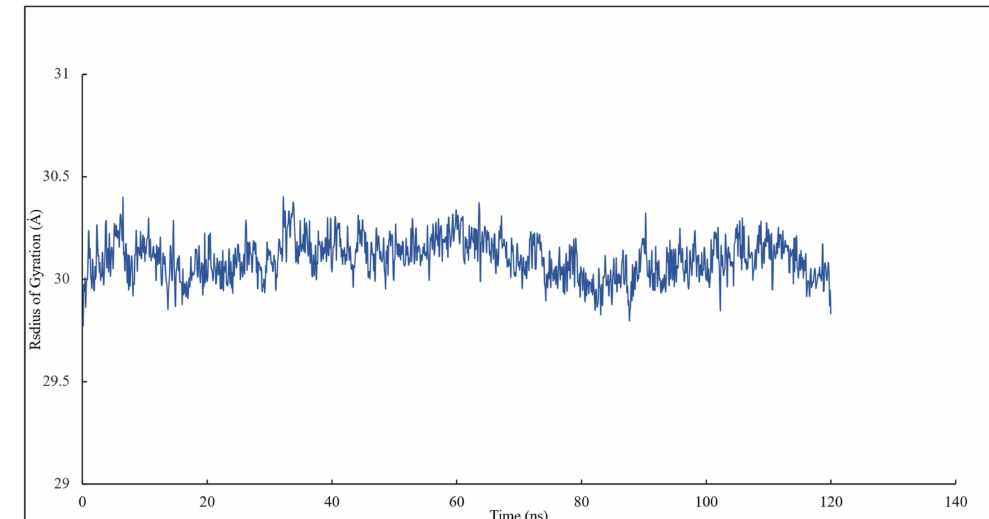
Figure 7. The radius of gyration of all residues and scoulerine in the colchicine binding site. Clustering Analysis